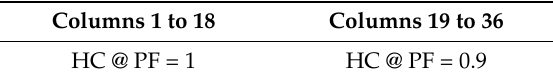
Table 4. Column Groups.